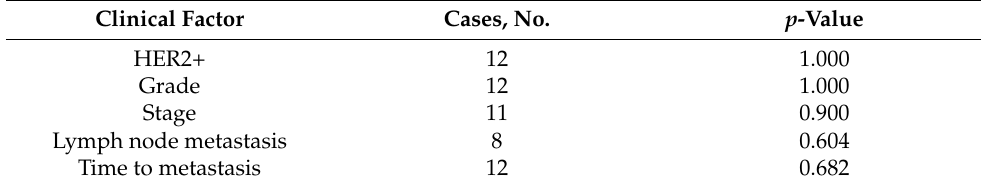
Table 10. Correlation between BiP subcellular localization and clinical factors in cohort 2. Clinical